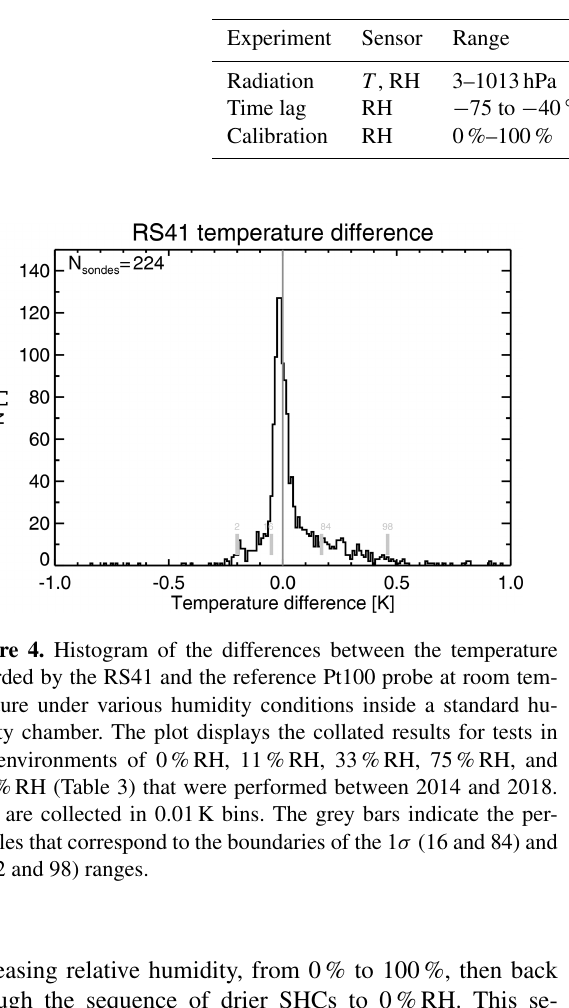
Table 4. Overview of laboratory experiments performed at the GRUAN Lead Centre to characterize the RS41 sensors.